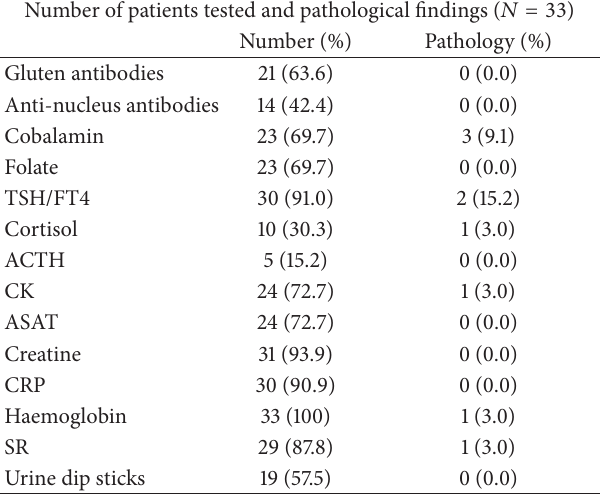
Table 2: Biochemical tests in a population of CFS children and